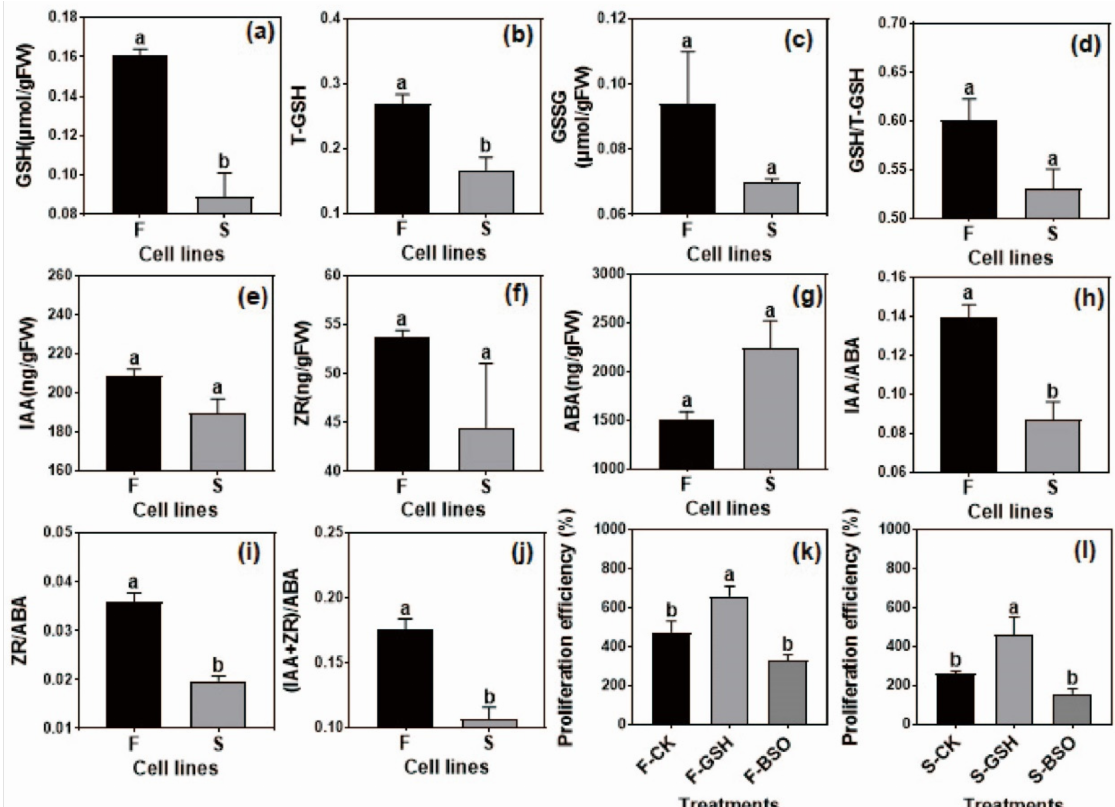
Figure 11. Intracellular GSH, hormones content, and fresh weight proliferation in F and S cell lines of Korean pine. Note: The average 3–4 biological replicates were counted for each treatment; ANOVA and Duncan’s tests were performed on the data in the figure, mean ± se, n = 5. Different lowercase letters at the same little figure indicate significant differences ( p < 0.05), ( a – d ) shows the content of glutathione in F and S cell lines, ( e – j ) shows the content of plant growth regulators in F and S cell lines, ( k , l ) shows the proliferation capacity of F and S cell lines exogenous addition of GSH and